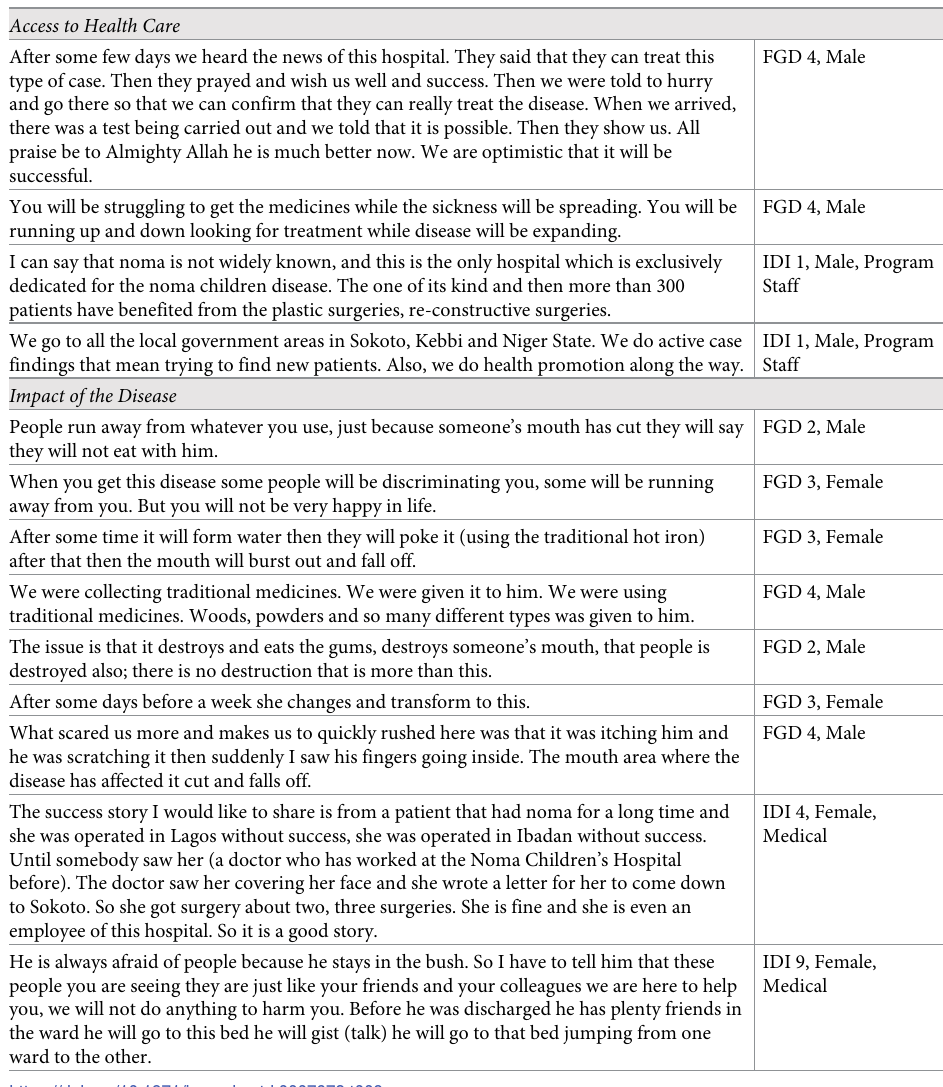
Table 3. Risks and consequences of noma with illustrative quotes. Access to Health